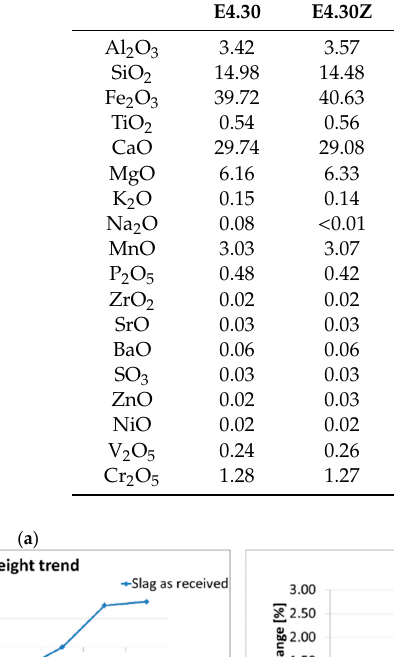
Table 8. Chemical composition of powders made of sintered slag pebbles: Cycled (E.30Z) and not cycled (E.30).